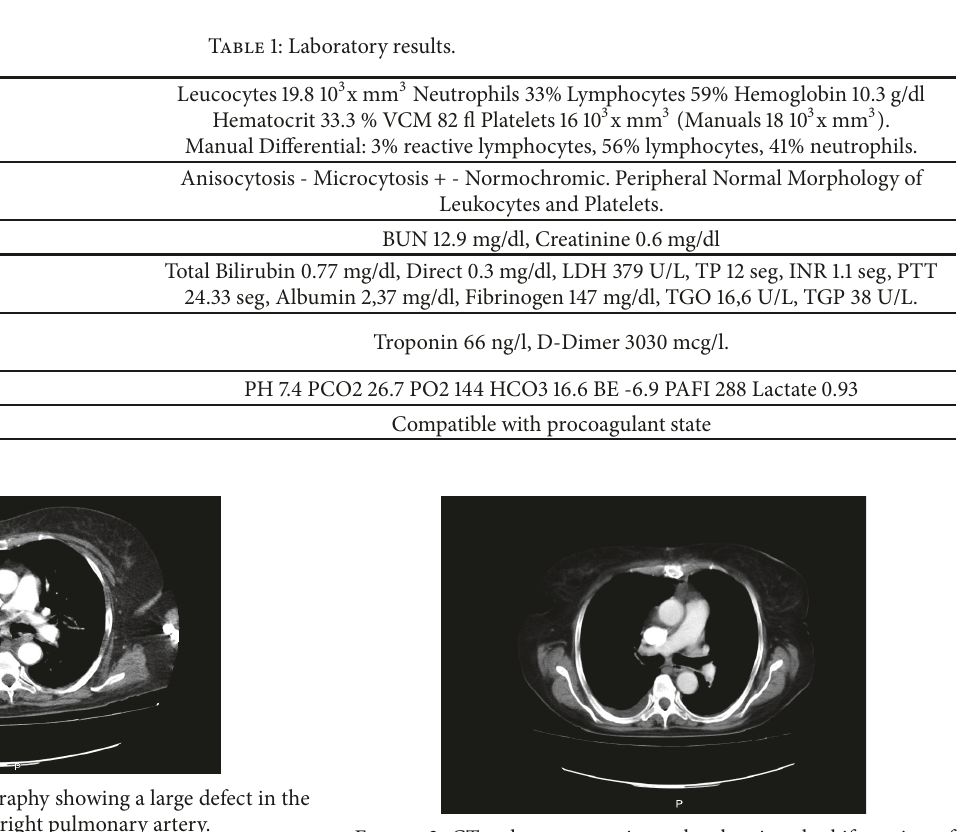
Figure 3: CT pulmonary angiography showing the bifurcation of the right pulmonary artery without